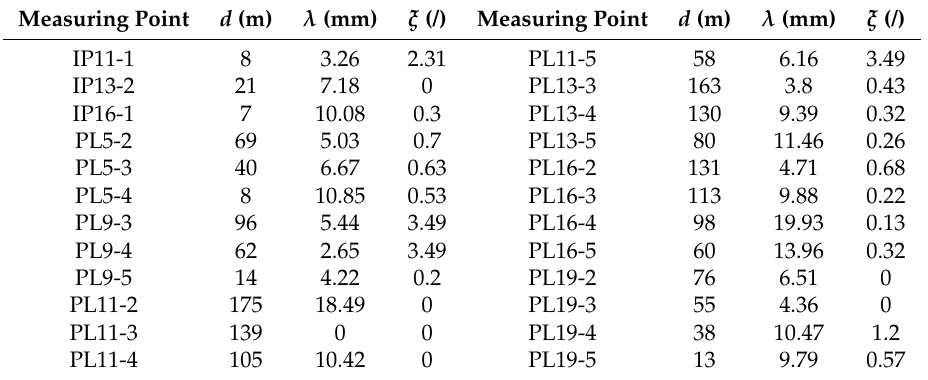
Table 1. Indicators d , ξ and λ calculated based on the ISODATA-GMM clustering